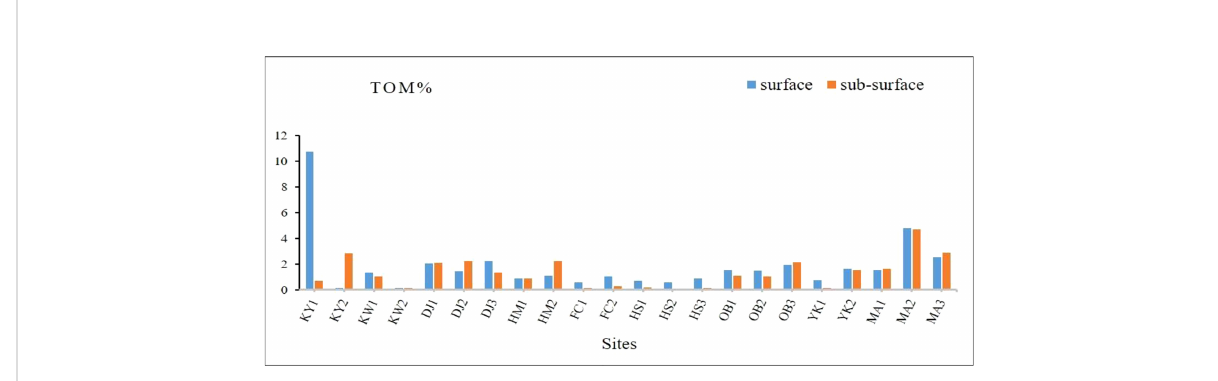
FIGURE 3 Total organic matter percentages of surface and sub-surface sediments at Siangshan wetland, Hsinchu,